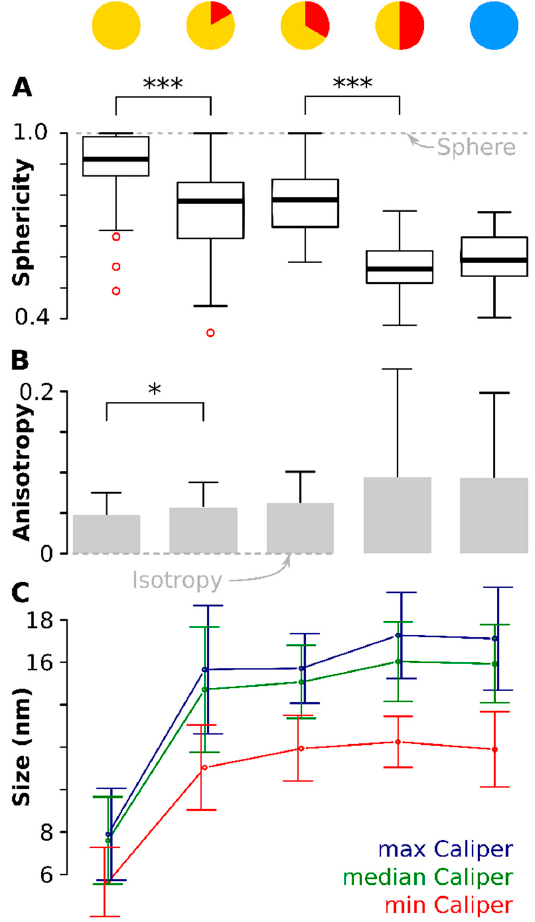
Figure 4. Particle anisotropy during the thermal decomposition process. ( A ) shows boxplots (because of the non-normal distribution) of the sphericity (1 = sphere, denoted by the dotted gray line). There is a significant drop ( p < 0.001) in sphericity of the particles between onset of the 320 °C plateau and again ten minutes later. A second drop (again p < 0.001) is observed between 20 min and 30 min after onset of the 320 °C plateau. The red circles denote outliers. ( B ) shows the anisotropy of the particles at different time points (0 = isotropy, denoted by the dotted gray line). Again, a significant difference ( p < 0.05) is seen between the situation at the onset of the 320 °C plateau and ten minutes later. ( C ) shows the development of the three orthogonal caliper lengths during the thermal decomposition. Plotted is the mean caliper of the longest, median and shortest axis. Note: for readability, the error bars are slightly shifted. * means p < 0.05; *** means p < 0.001. The direction of the maximum caliper was calculated for each particle (see Figure A4 for a graphical representation of the methodology) and represented by the two angles ϕ - rotation along the x -axis - and θ - rotation along the Y axis had an optimum at all time points in the broad vicinity of 90° (Figure 5A). Most significantly, after rotating each particle degrees (i.e., aligning the maximum anisotropy component in the XY orthogonal plane), a preferred orientation of the particles on the TEM grid was observed: there was an aversion for θ = 90° (the rotation in the Y-plane) but a preference peaked for θ at 69° and 111° (Figure 5B). The smaller particles at the onset (red in Figure 5) had the narrowest—rotation peak, which also aligned the closest to 90° in the rotation. The same was observed for the θ : the earlier stage had narrower peaks and was found closer to the 90° minimum. The entire scatter diagram can be consulted in Figure A5.